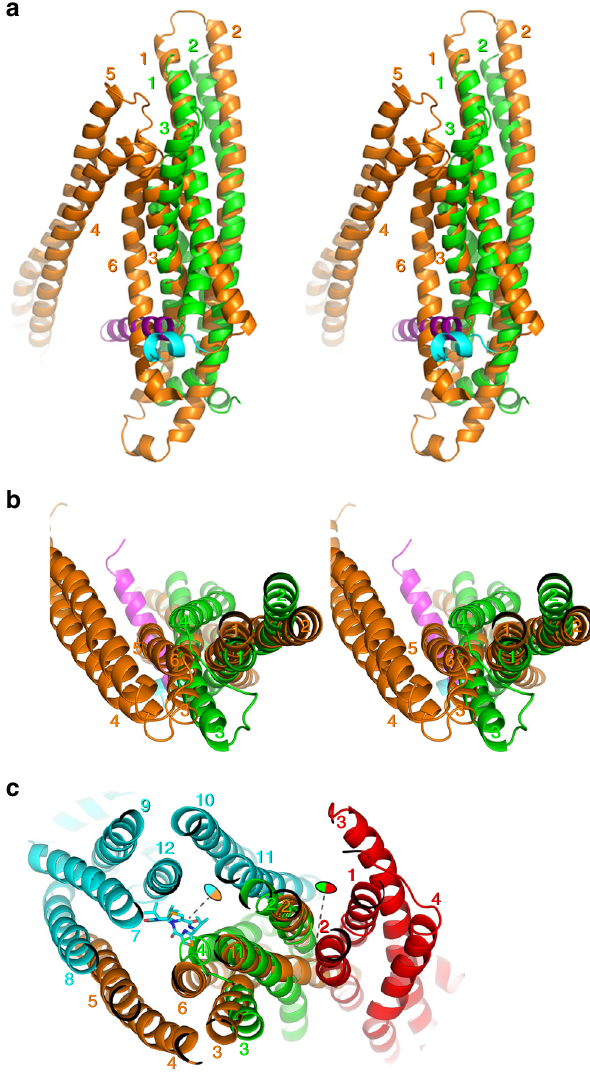
Fig. 7 Superimposition of helix bundles of MacB and mouse ABCB1a. a , b MacB monomer and N-terminal half of ABCB1a are superimposed (in stereo view) according to the top hit of the fold match program DALI. MacB (green) and ABCB1a (PDB accession code: 4M1M; orange) 32 are shown in ( a ) side view and ( b ) top view. TMs are numbered. TM1-3 from each transporter are essentially overlapping with high Z -score ( z = 8.0). Elbow helices of MacB and ABCB1a are coloured in magenta and cyan, respectively. c Functional unit of MacB and ABCB1 are shown in a similar orientation as in b . Two monomers of MacB are coloured in green and red. Two halves of ABCB1a are coloured in cyan and orange. Monomer A (green) in dimeric MacB is superimposed on N-terminal half of mouse ABCB1a (PDB accession code: 4M2S; N-terminal half coloured in orange) 32 . Inhibitor, QZ59-RRR ((4R,11R,18R)-4,11,18-tri(propan-2-yl)-6,13,20- triselena-3,10,17,22,23,24-hexaazatetracyclo [17.2.1.1 ~ 5,8 ~ .1 ~ 12,15~] tetracosa-1(21),5(24),7, 12(23),14,19(22)-hexaene-2,9,16- trione)) in the substrate binding pocket between TM1, TM6, TM7 and TM12 of ABCB1a is indicated in stick representation. Biological twofold symmetric axes on each transporter are shown by dotted lines and coloured